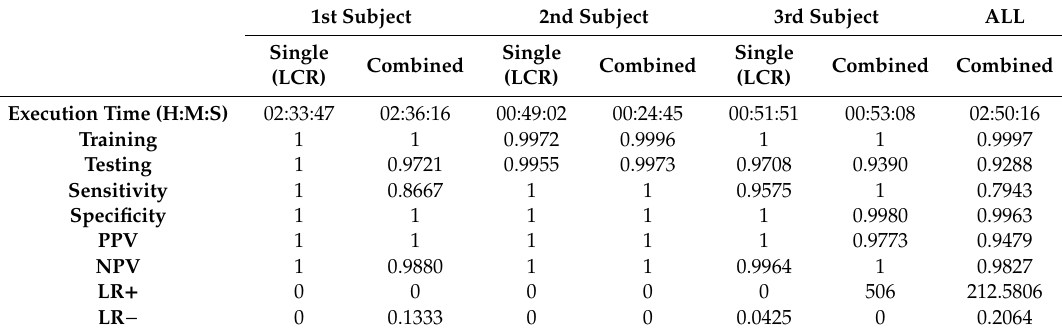
Table 3. Comparison between first subject, second subject and third subject using CNN for overall (Training and Testing)